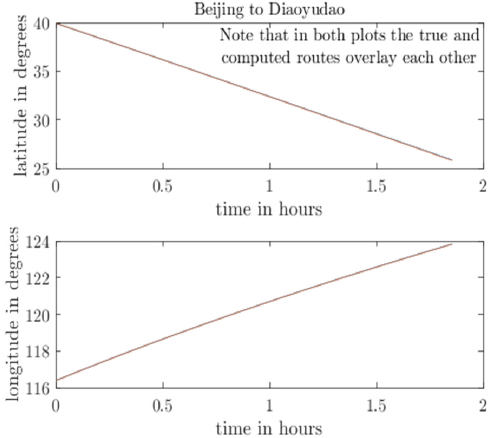
Figure 2. Ideal great circle trajectory.